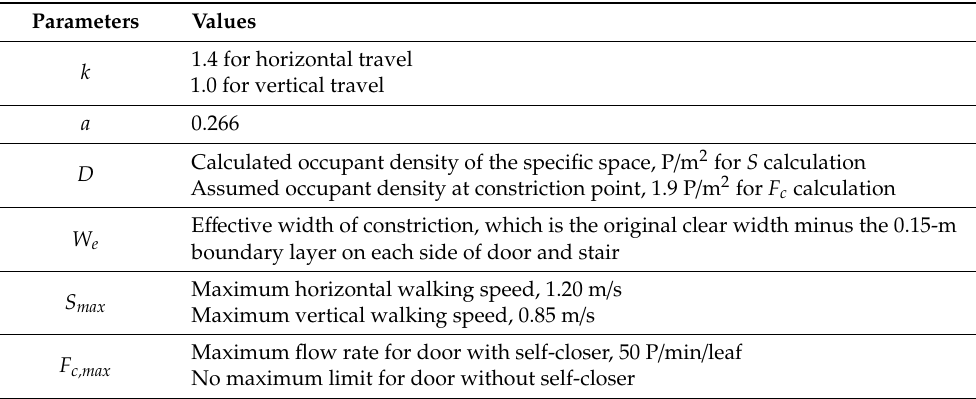
Table 3. Constants and maximum values for walking speed and flow rate